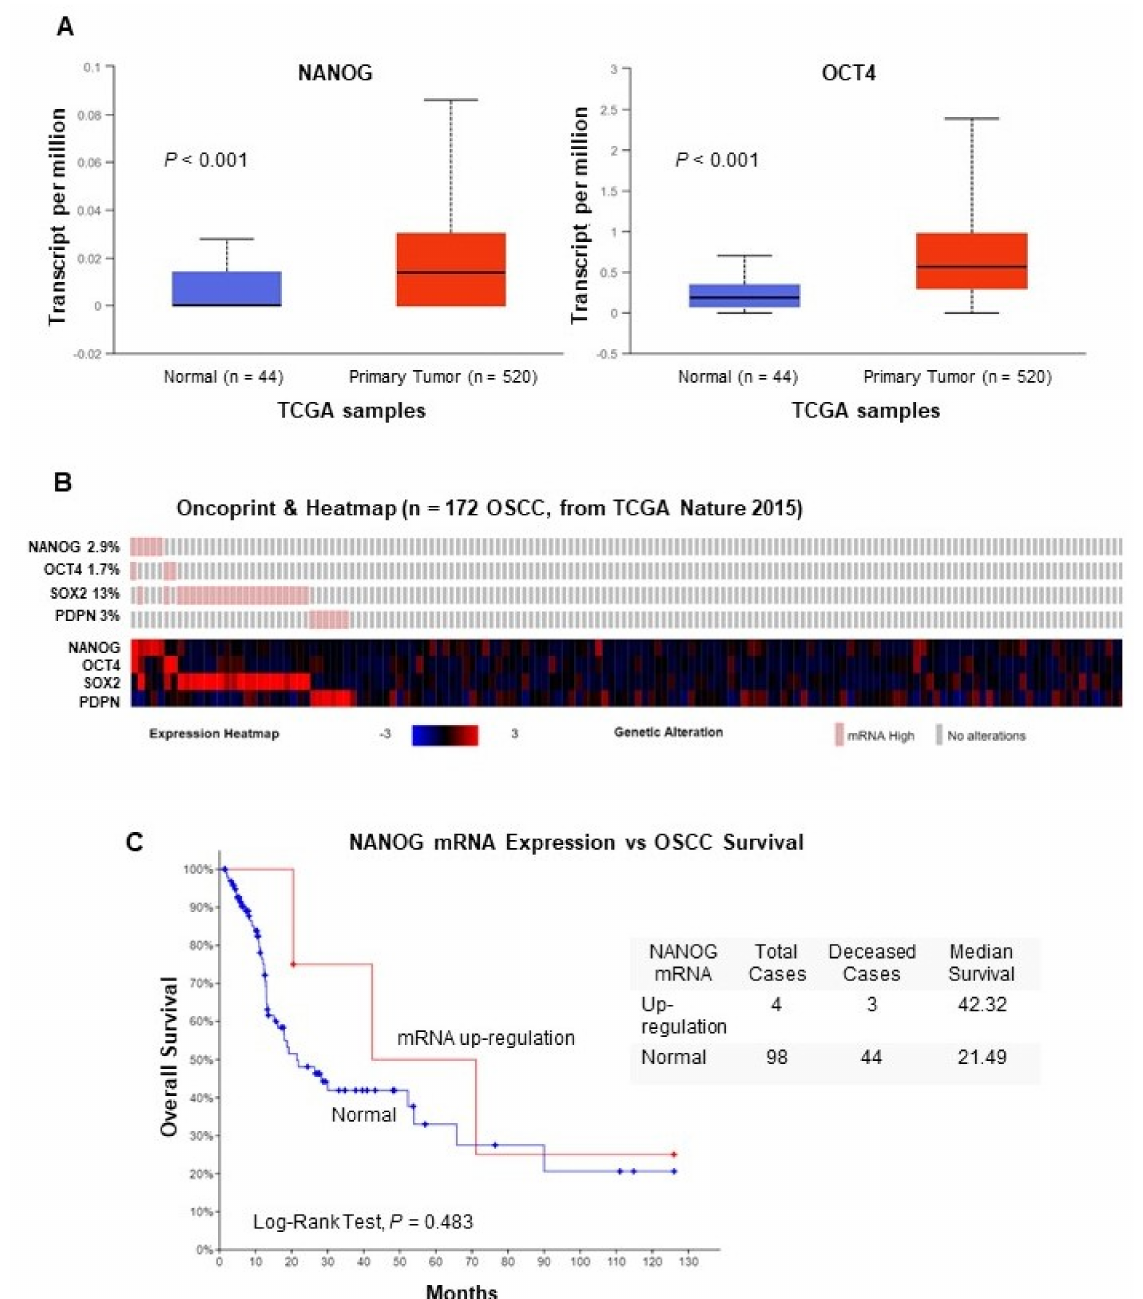
Figure 3. Analysis of NANOG and OCT4 mRNA expression using RNAseq data from the The Cancer Genome Atlas (TCGA) head and neck squamous cell carcinomas (HNSCC) cohorts. ( A ) Box plots comparing the mRNA expression levels of NANOG and OCT4 in primary tumors (in red) VS. normal tissue (in blue) in the TCGA cohort of 530 HNSCC patients using the UALCAN online resources (http: // ualcan.path.uab.edu / ). ( B ) Oncoprint and heatmap representations showing the percentage of cases with mRNA upregulation of each CSC-related gene assessed in the subset of 172 OSCC patients from the TCGA HNSCC cohort [19]. ( C ) Kaplan–Meier survival curves categorized by NANOG mRNA expression (RNA seq V2 RSEM, z -score threshold ± 2) dichotomized as normal vs. upregulation, P value estimated using the Log-rank